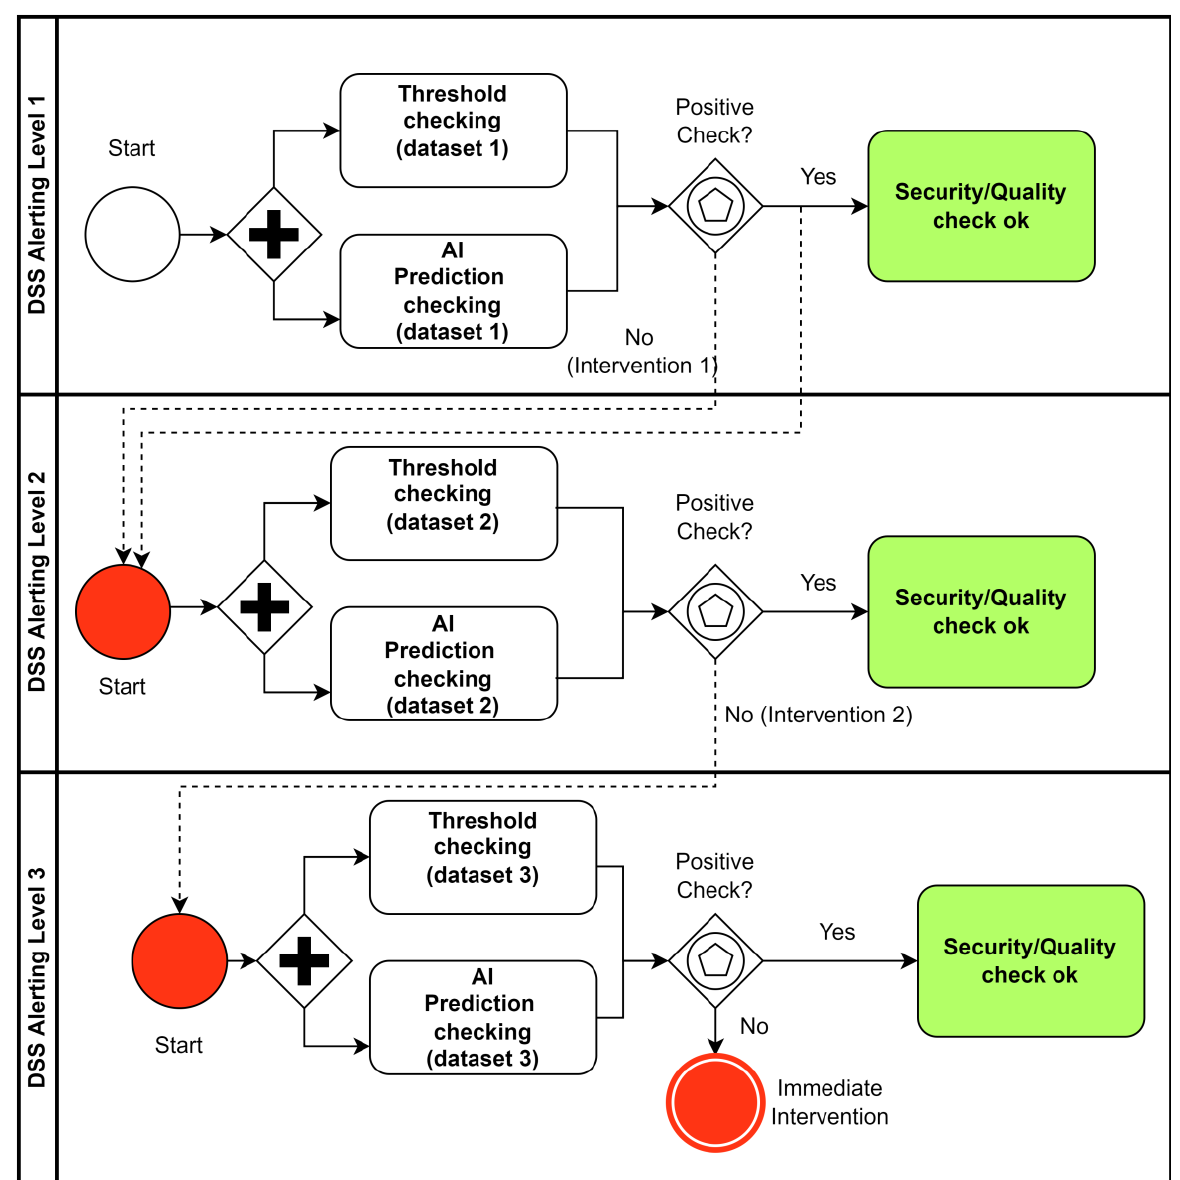
Figure 2. PM BPMN model describing the “ proof of concept ” of Figure 1 by considering three DSS levels (model simplified).